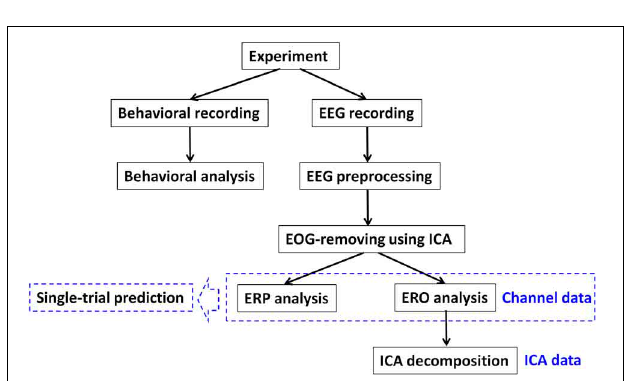
subsequent trials, which means he/she decides to stay in the “99” option in the subsequent trial rather than to switch to the “9” option.